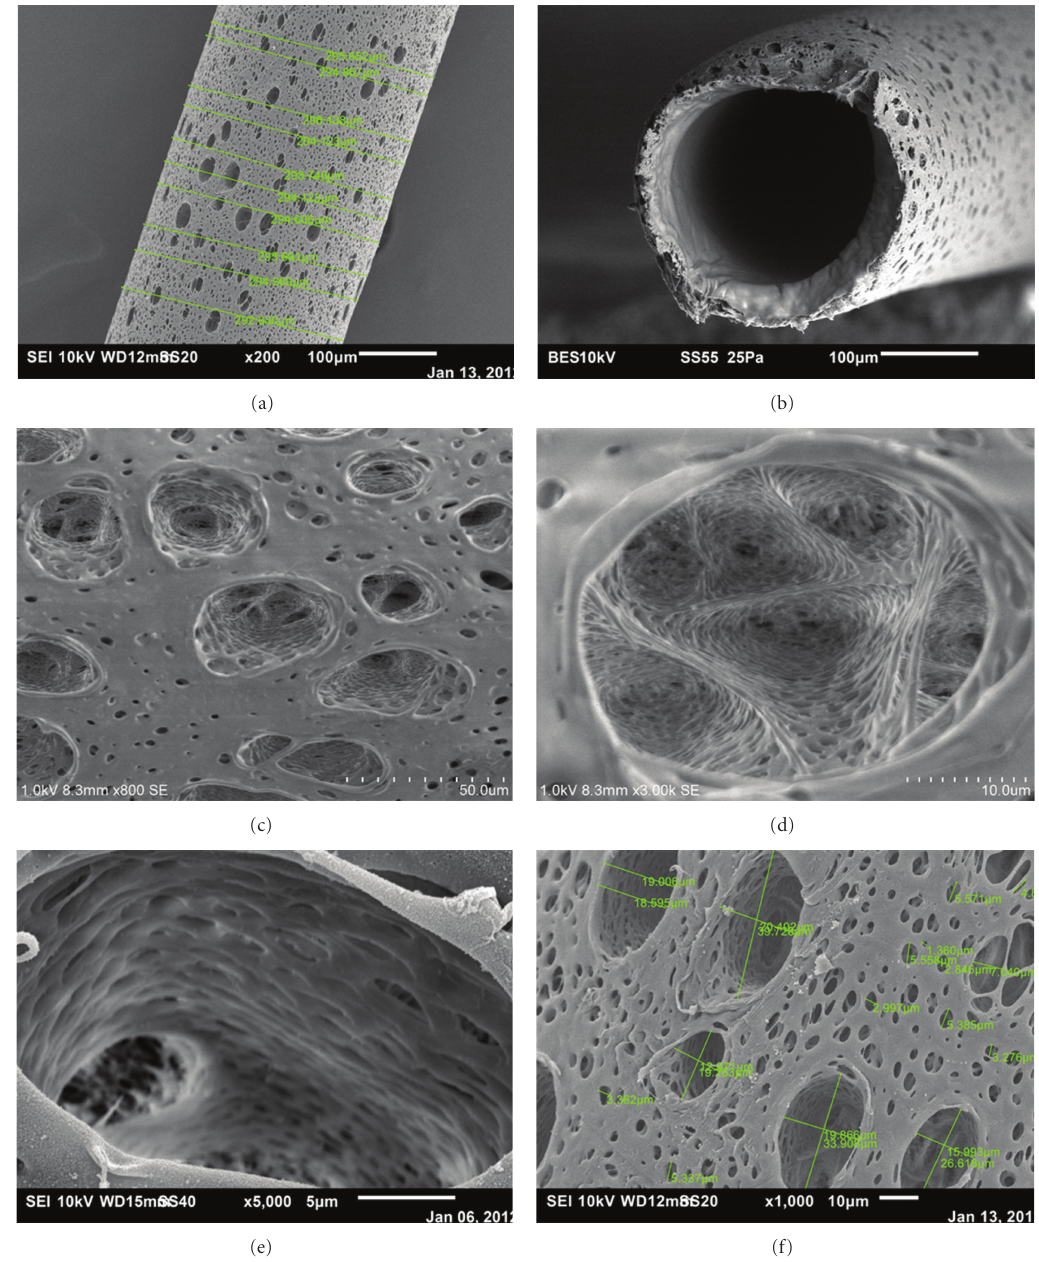
Figure 1: (a) Outer surface of a Polyflux capillary at 200x with measurements, (b) view of the cross section of a Polyflux capillary at 250x, (c) morphology of outside pore in contact with the dialysate at 800x, (d) morphology of outside pore in contact with the dialysate at 3000x, (e) morphology of outside pore in contact with the dialysate at 5000x, and (f) pores on the dialysate side of the Polyflux 210H capillary at 1000x with